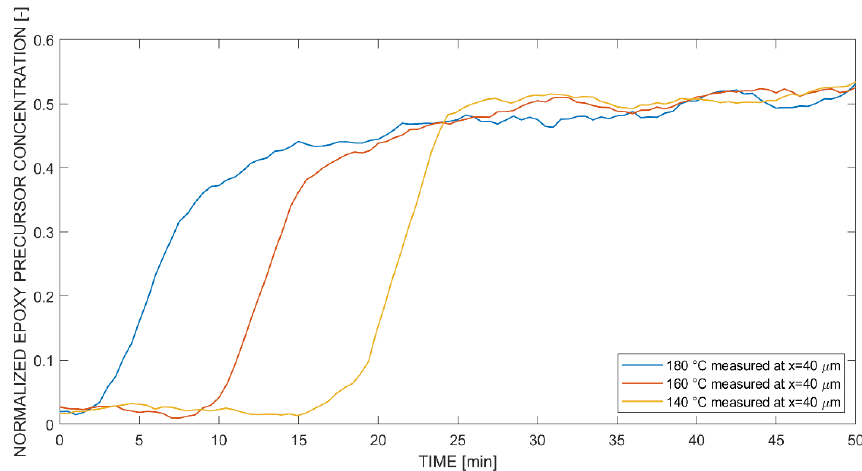
Figure 8. Temperature-dependent concentration curves normalized to Raman intensity amplitude 1819@988 cm −1 at coordinate x = 40 μm (positive) for diffusion of the (monocomponent) epoxy precursor into PEI.